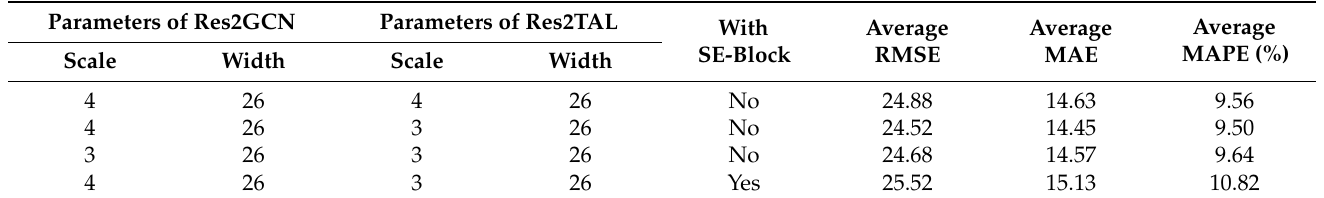
Table 3. Influence of changes of the Res2Net structure on the model (with PeMS08 as an example). Parameters of